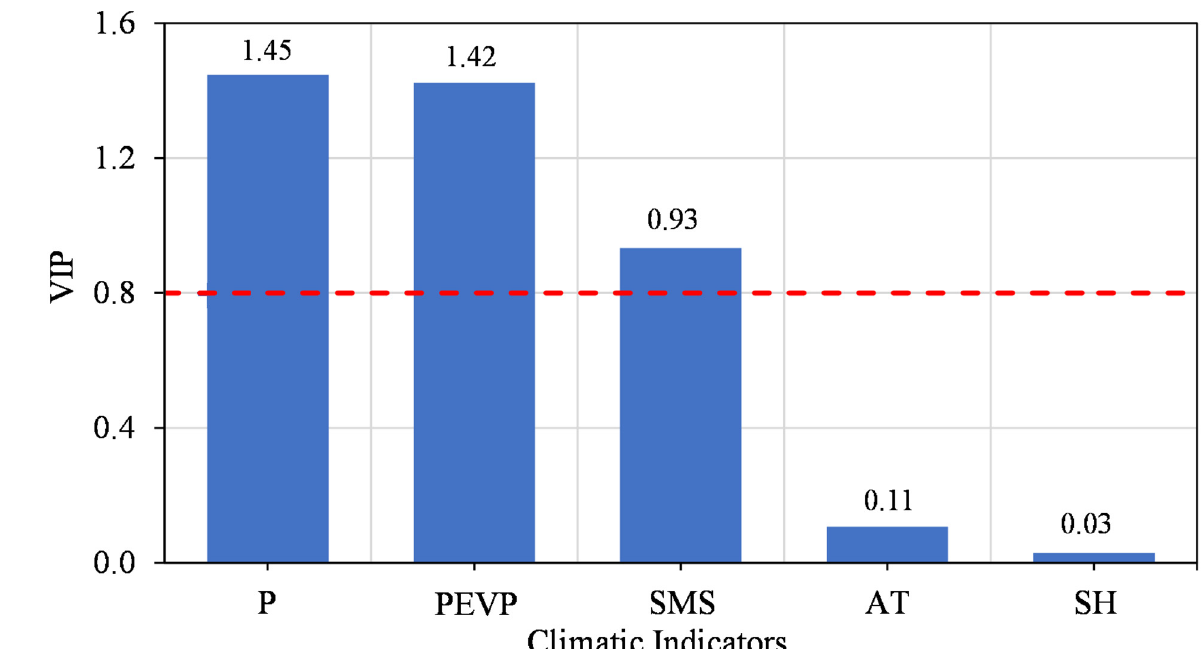
Figure 11. The effect of several climatic indicators on drought from 2003 to 2016 is based on the PLSR model.